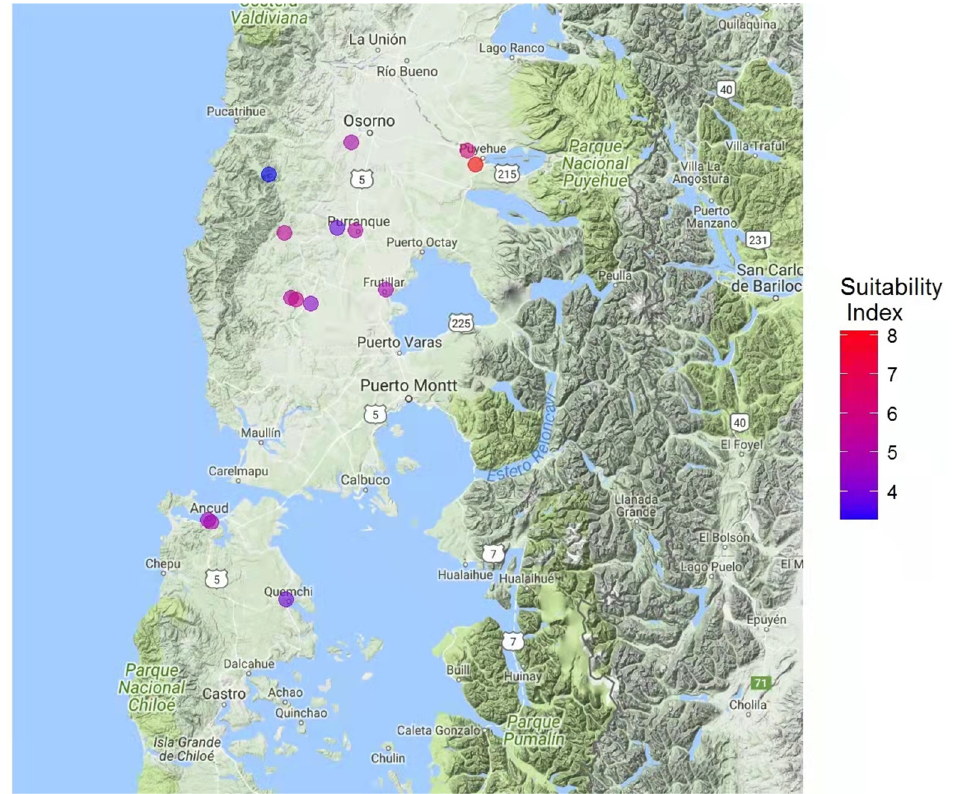
Figure 6. Map of the Los Lagos Region (Chile, 39 ◦ 16 (cid:48) S to 44 ◦ 04 (cid:48) S) indicating the most suitable areas for apiculture. The suitability index is indicated by a color scale going from blue (more suitable) to red (less